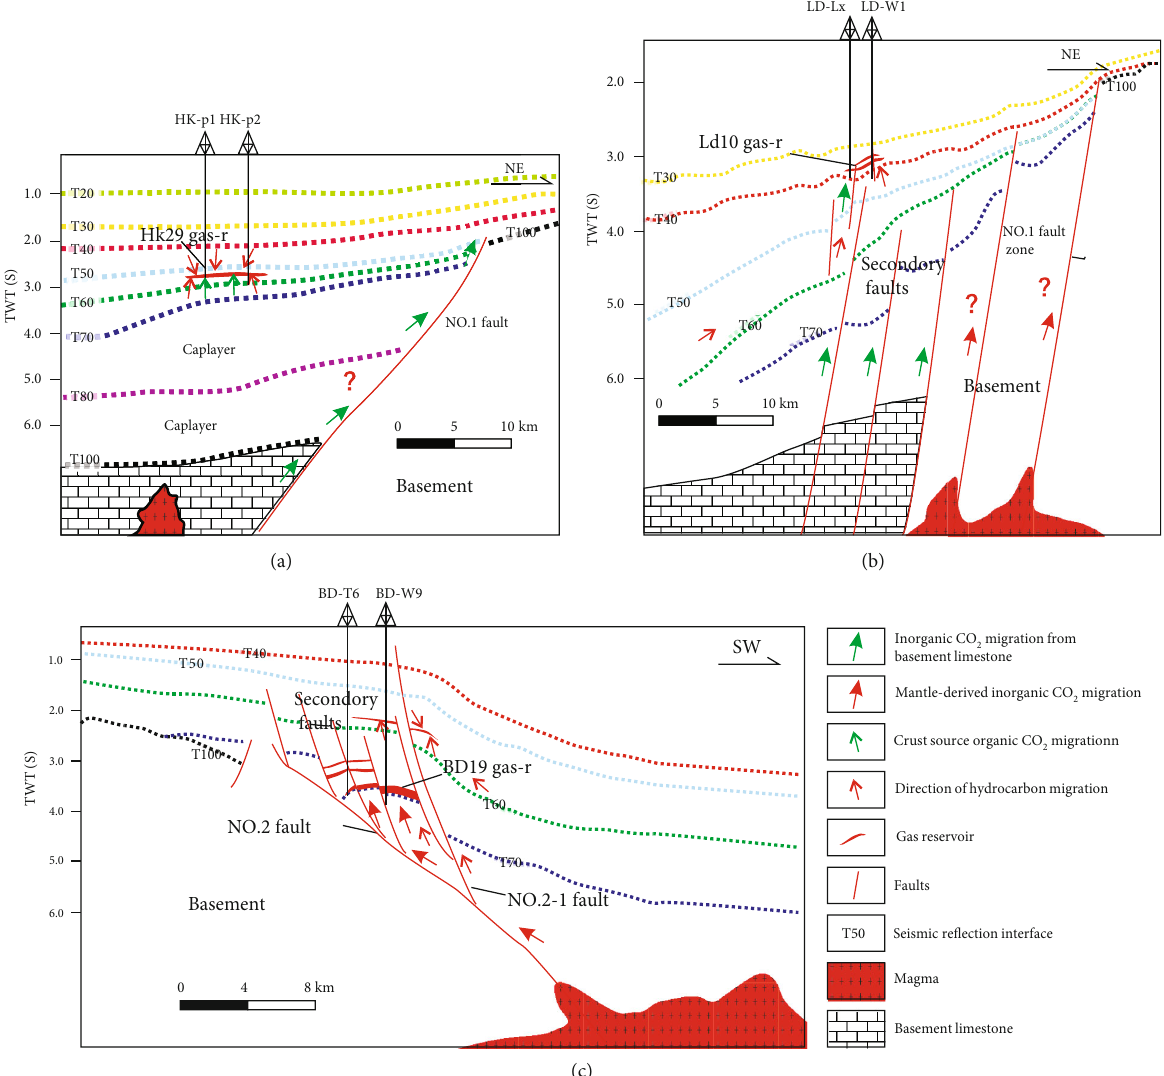
Figure 11: The e ff ect of di ff erent fault structures on natural gas charging modes. (a) HK29 gas reservoir formation model. (b) LD10 gas reservoir formation model. (c) BD19 gas reservoir formation